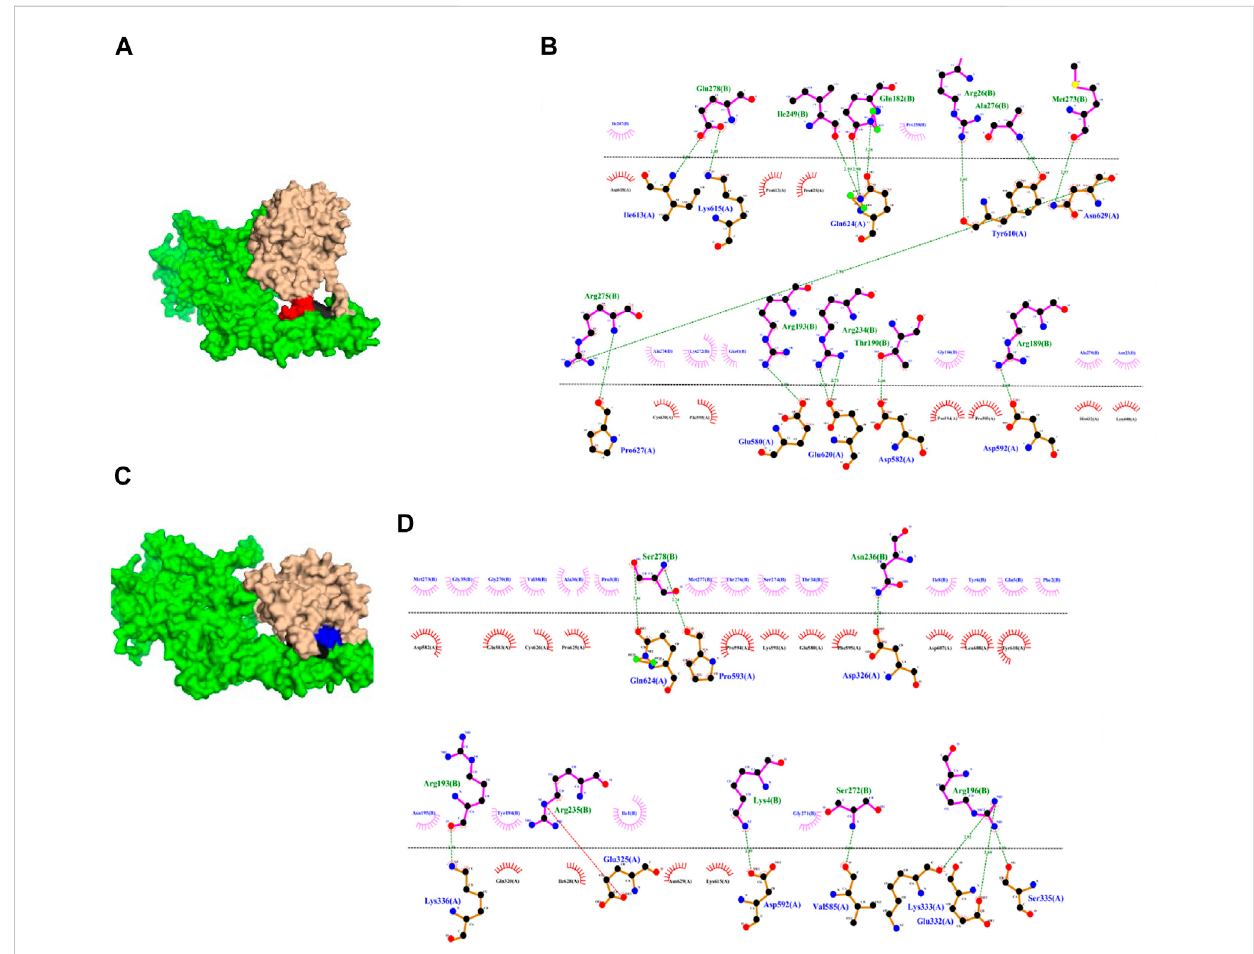
theinteractionbetweenCPs2 (A,B) and10 (C,D) withErbB2(green).Ricin A isdepictedinsalmon,whilelinkersareshowninblack.PeptidesMARAKE, and MSRTMS are colored red and blue, respectively.